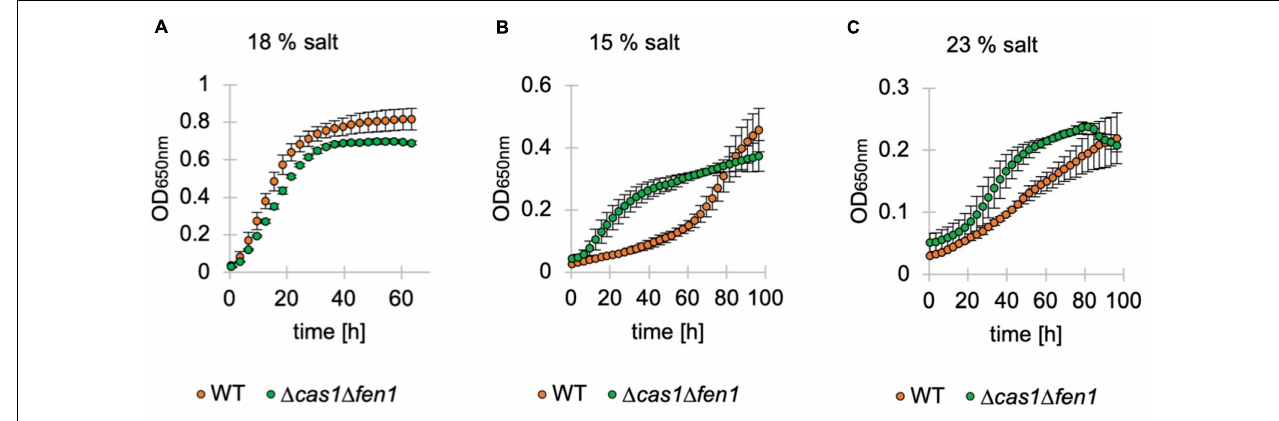
FIGURE 4 | Growth of deletion mutants in standard, low and high-salt conditions. Growth of Haloferax volcanii wild-type (orange) and deletion strains (green) under standard (18%) (A) , low (15%) (B) and high (23%) (C) salt conditions in Hv-YPC medium. Vertical lines represent standard deviation at different measuring points of three independent experiments. The x-axis shows the time of growth and the y-axis the OD 650nm .